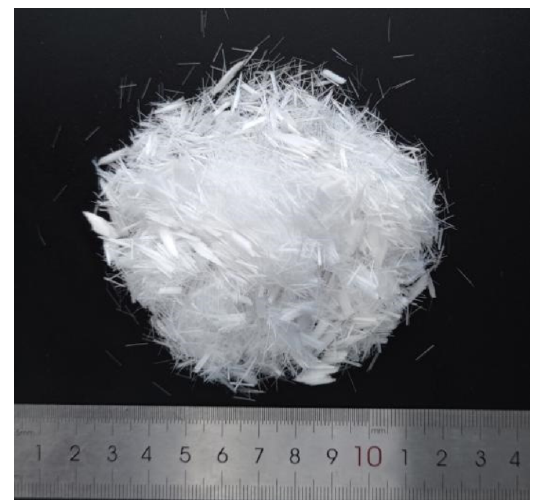
Figure 2. Polypropylene fiber.